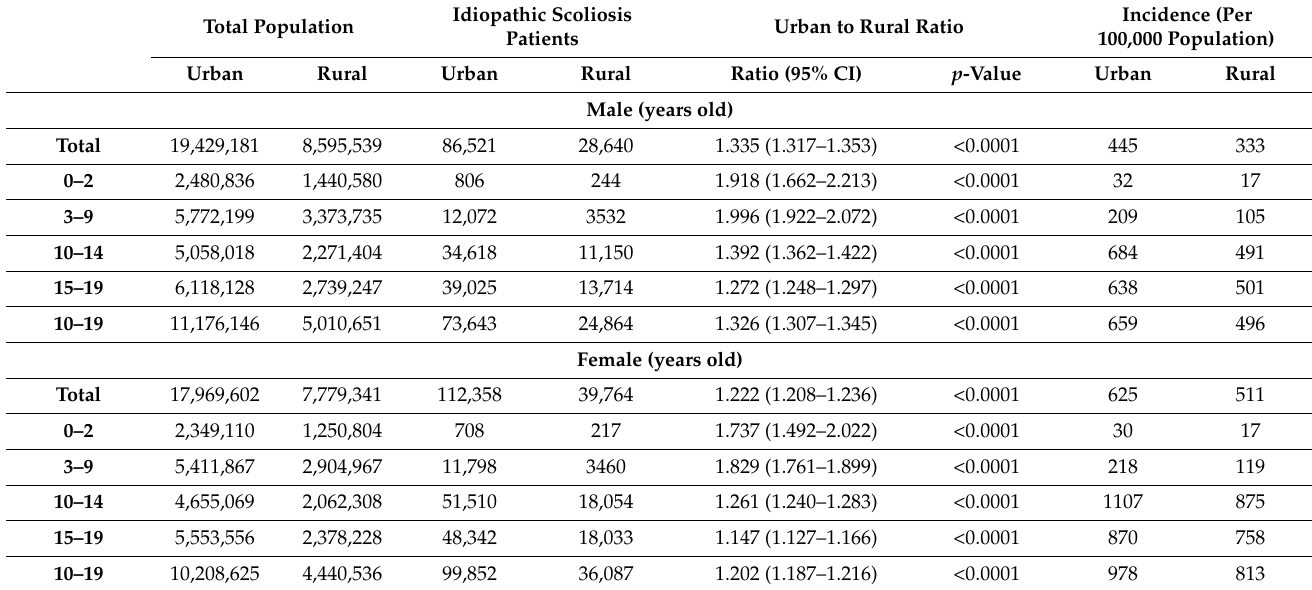
Table 3. Regional incidences of idiopathic scoliosis in males and